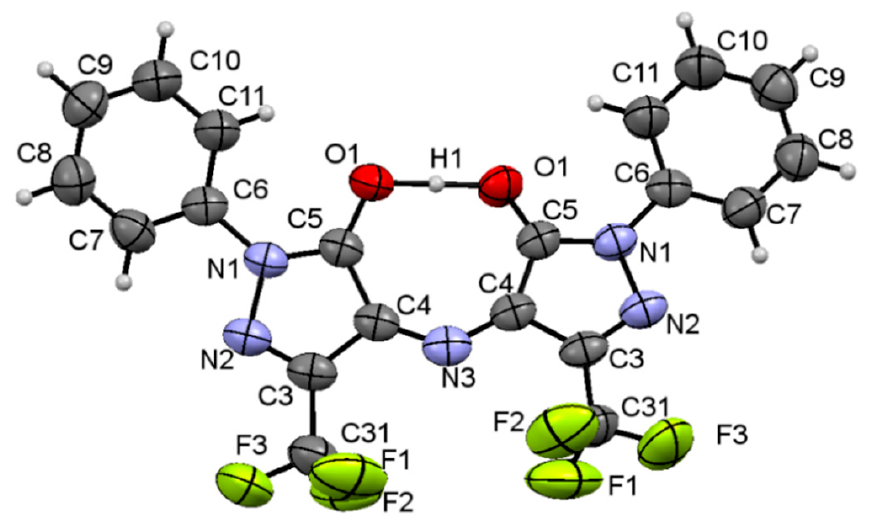
Figure 1. The structure of compound 2a according to XRD.